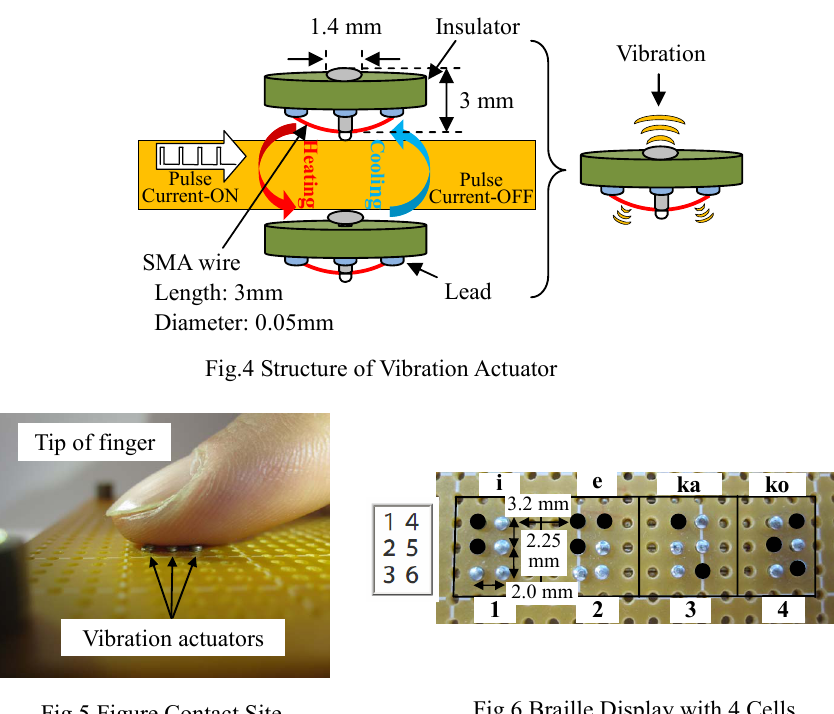
Fig.5 Figure Contact Site